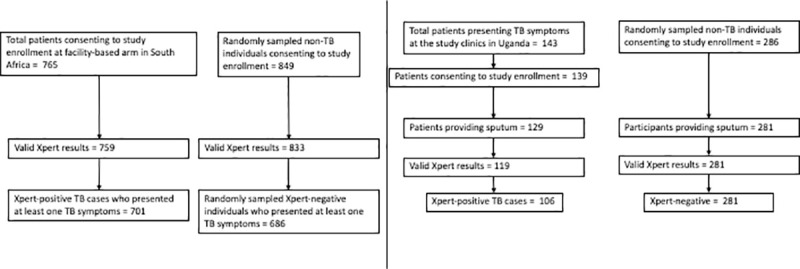
Flow chart of the South African and Ugandan study population.Left panel shows the flow chart of the South African study population. Laboratory registers were used to randomly select 1 Xpert–negative patient for every Xpert–positive patient enrolled. After excluding those who did not report any TB symptoms, the final ratio between Xpert–positive TB cases (n = 701) and Xpert–negative individuals (n = 686) became 1.02:1. Right panel shows the flow chart of the Ugandan study population. Clinical registers of patients with presumptive TB were used to select 2 Xpert–negative patients per Xpert–positive patient. The final ratio of Xpert–positive TB cases (n = 106) to Xpert–negative individuals (n = 281) was 0.38:1. In both studies, controls were matched to cases based only on facility and date range of clinical presentation. TB, tuberculosis.